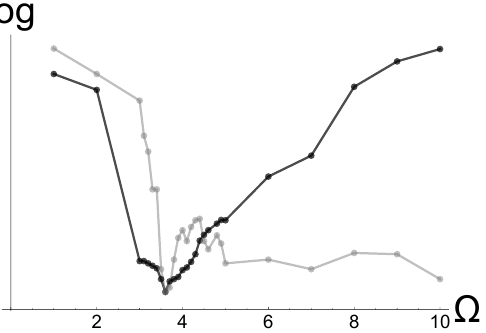
Figure 8. Exemplary plot of reconstruction energy (black) and condition number (gray) over Ω . The ordinate is logarithmic and aligned at the minimum at Ω opt =